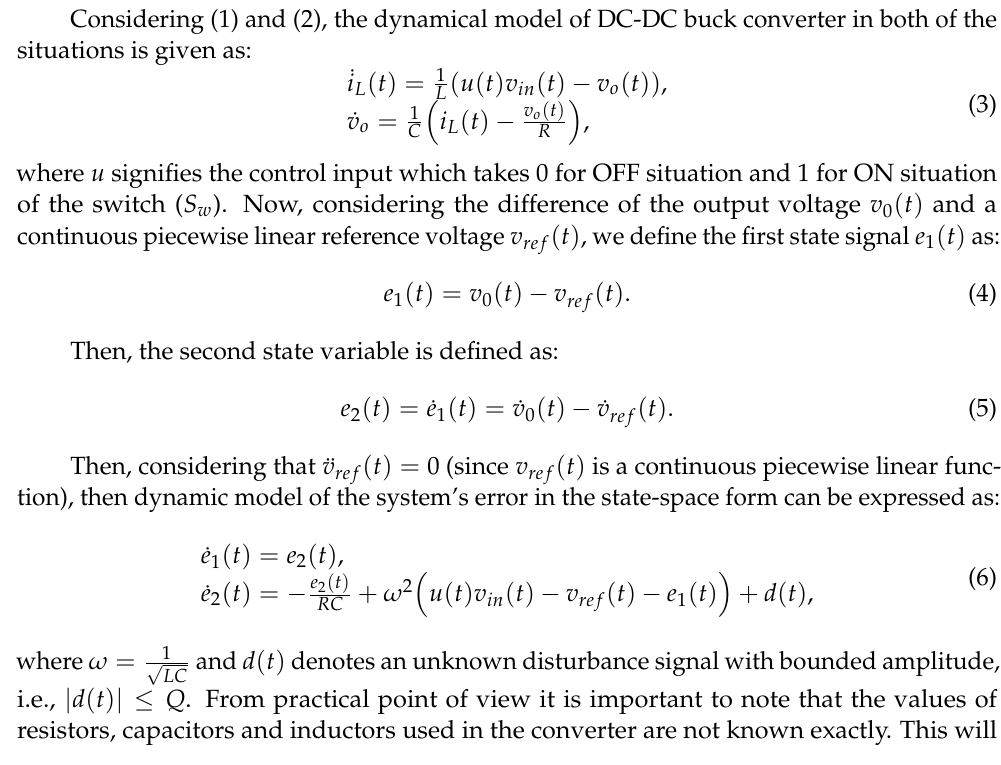
Figure 1. The DC-DC buck converter model in